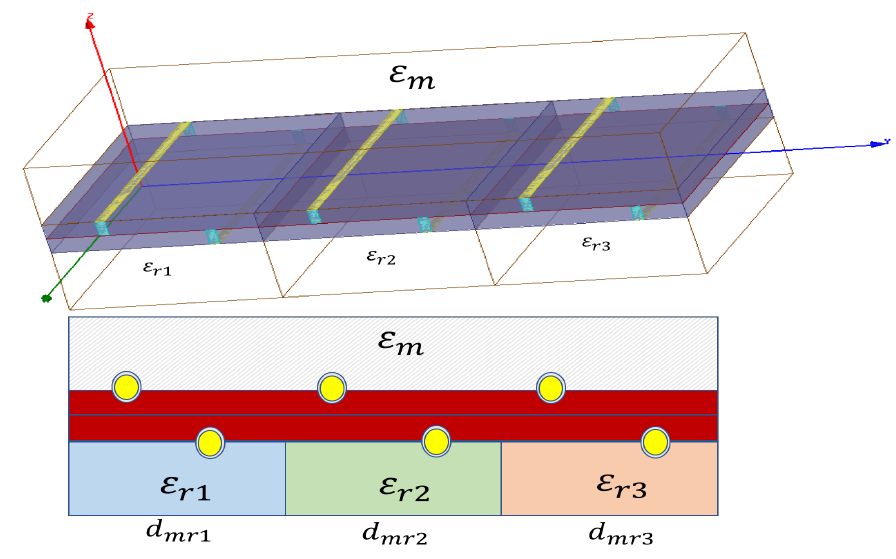
Figure 15. Configuration of a sensor microstrip that detect low, medium or high permittivity levels in applications where permittivity must be